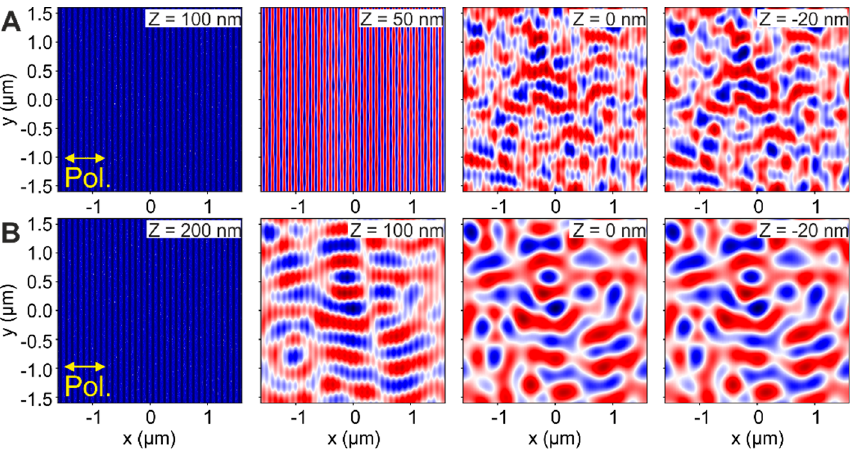
Figure 9. FDTD- intensity distribution at different Z -positions along the beam axis for two different layered systems with HSFL modulation depth d HSFL = 50 nm and. In ( A ) the oxide layer thickness is T ox = 100 nm and in ( B ) T ox = 200 nm. The interface between the oxide layer and the CrN is located at Z = 0 nm. The plots at Z = − 20 nm in both cases correspond to intensities calculated 20 nm inside the CrN from the oxide-nitride interface. The laser beam ( λ = 800 nm) polarization direction is horizontal. The colors of the intensity plots are encoded in a false color scheme where red indicated deviations above and blue below the average intensity value of the image, represented in white.